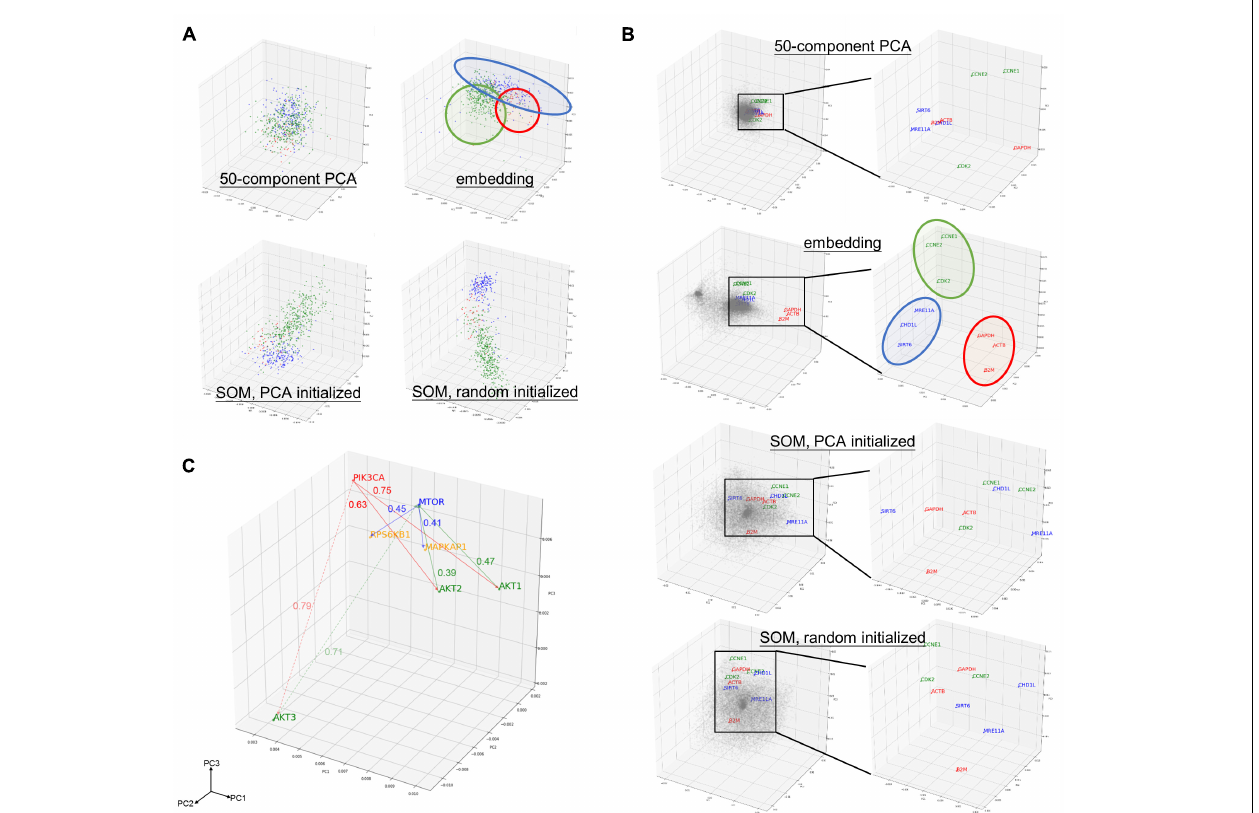
FIGURE 2 | Preservation of relationship and the properties of entity model. (A) PCA projection of hepatobiliary and pancreatic cancers [liver hepatocellular carcinoma/LIHC (green), cholangiocarcinoma/CHOL (red), and pancreatic adenoma/PAAD (blue)] from (upper left) 50-compenet PCA projection of raw log 2 gene expression level; (upper right) sample entity matrix; (lower left) SOM with PCA initialized map, and; (lower right) SOM with random initialized map. Sample relationship are preserved by the embedding model even with dramatically reduced dimensions (20531 to 50). (B) PCA projection of all 20531 genes from (1st row) 50-compenet PCA projection of raw log 2 gene expression level; (2nd row) gene entity matrix; (3rd row) SOM with PCA initialized map and; (4th row) SOM with random initialized map. Housekeeping genes ( GAPDH , ACTB , B2M ) are highlighted in red. Housekeeping genes are clustered together in gene entity matrix,